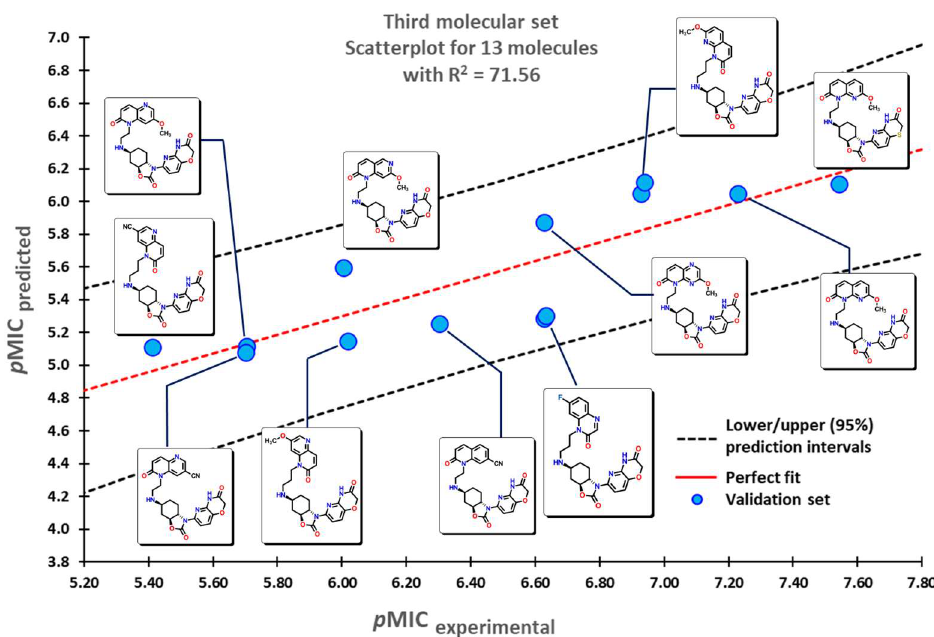
Figure 6. Scatterplot for oxazolidinone derivatives used for the validation of the QSPR model. Selected molecules are displayed within the plots.